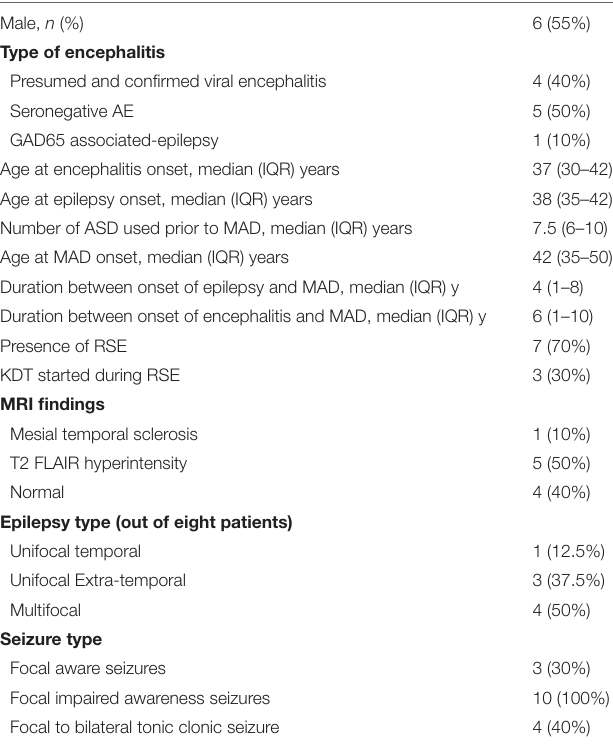
TABLE 1 | Baseline characteristics of patients with post-encephalitic and auto-immune associated epilepsy treated with the modified Atkins diet. Male, n (%) 6